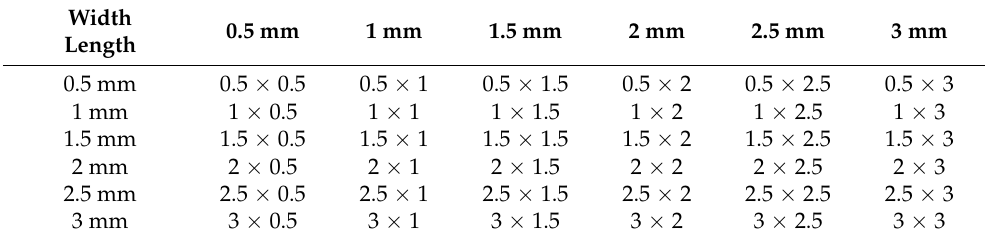
Figure 3. The structures of the bifurcated fractures (the contact area is defined as fracture A, that without contact area is defined as fracture B). ( a – f ): same cross-section and different areas (the cross-section is 3 mm); and ( g – l ): same area and different cross-sections (the contact area is 9 mm 2 ). Table 1. Setting of contact area in fracture model: the same cross-section and different contact areas.